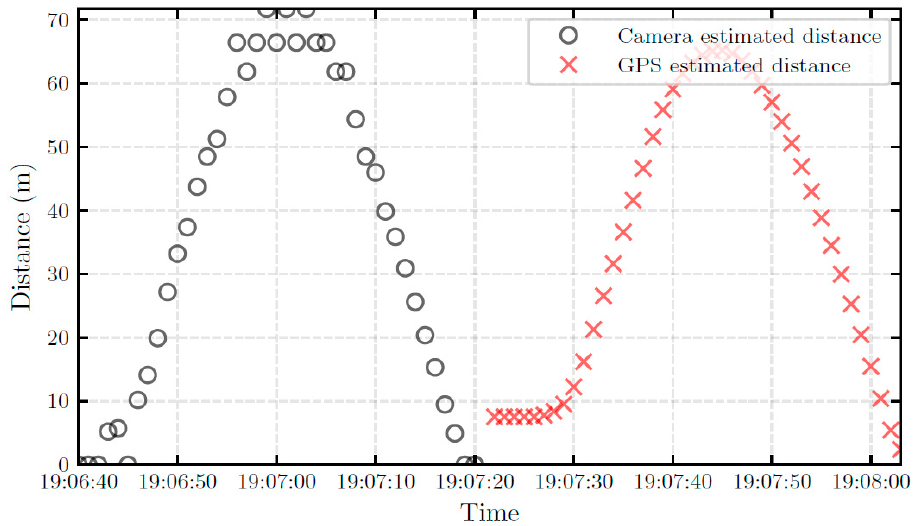
Figure 5. Comparison of the GPS and camera distance estimation .